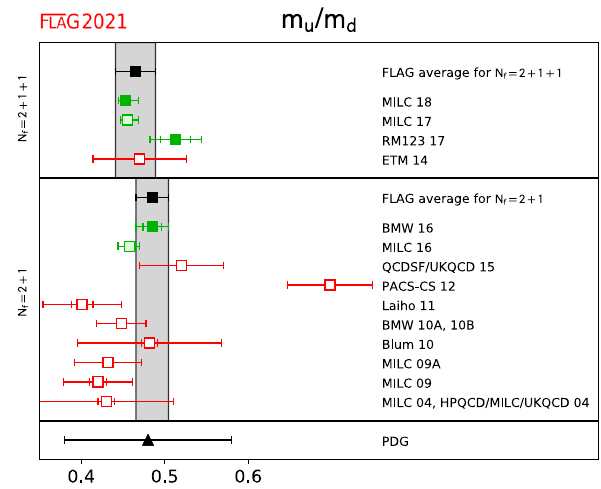
Fig. 4 Lattice results and FLAG averages at N f = 2 + 1 and 2 + 1 + 1 for the up-down-quark masses ratio m u / m d , together with the current PDG estimate